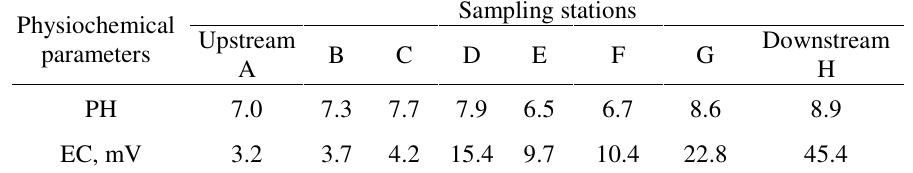
Table 1. Physicochemical parameters of water in various sampling stations